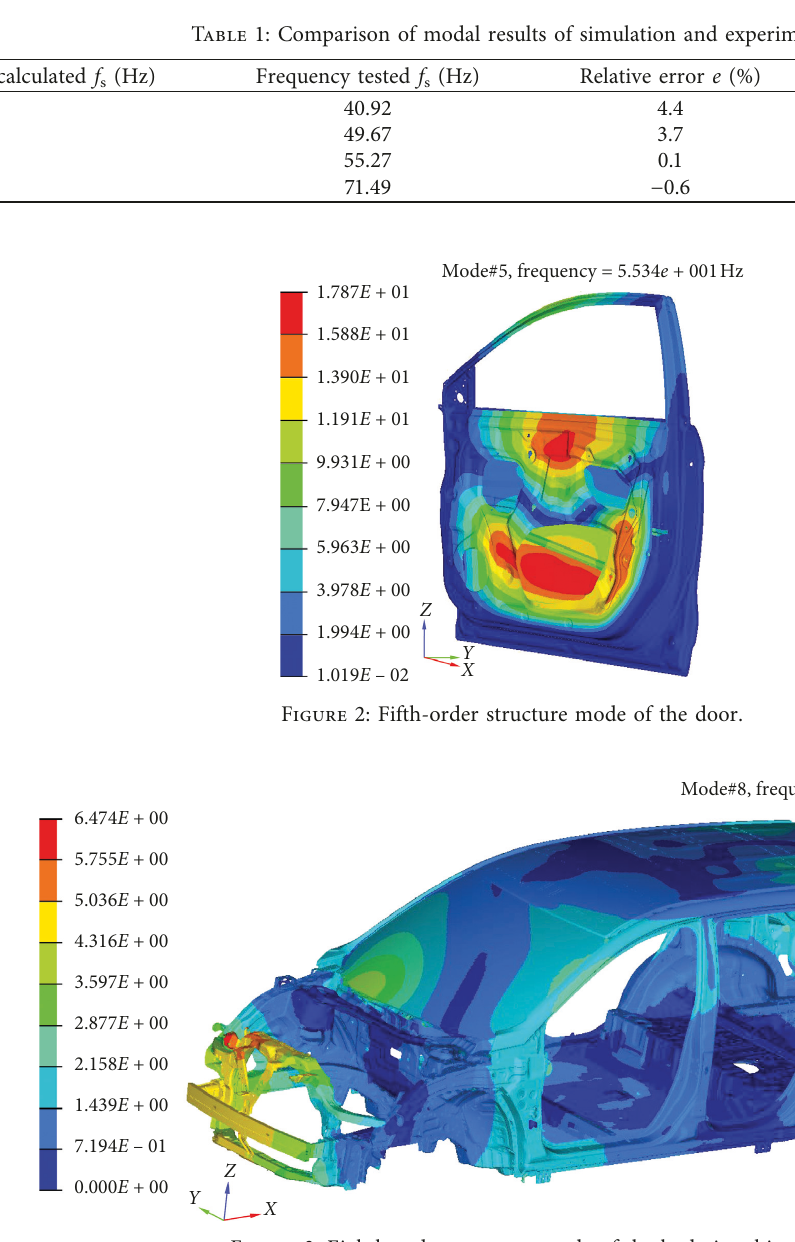
Figure 3: Eighth-order structure mode of the body in white. Table 2: Sensitivity of the fifth-order modal frequencies to panel